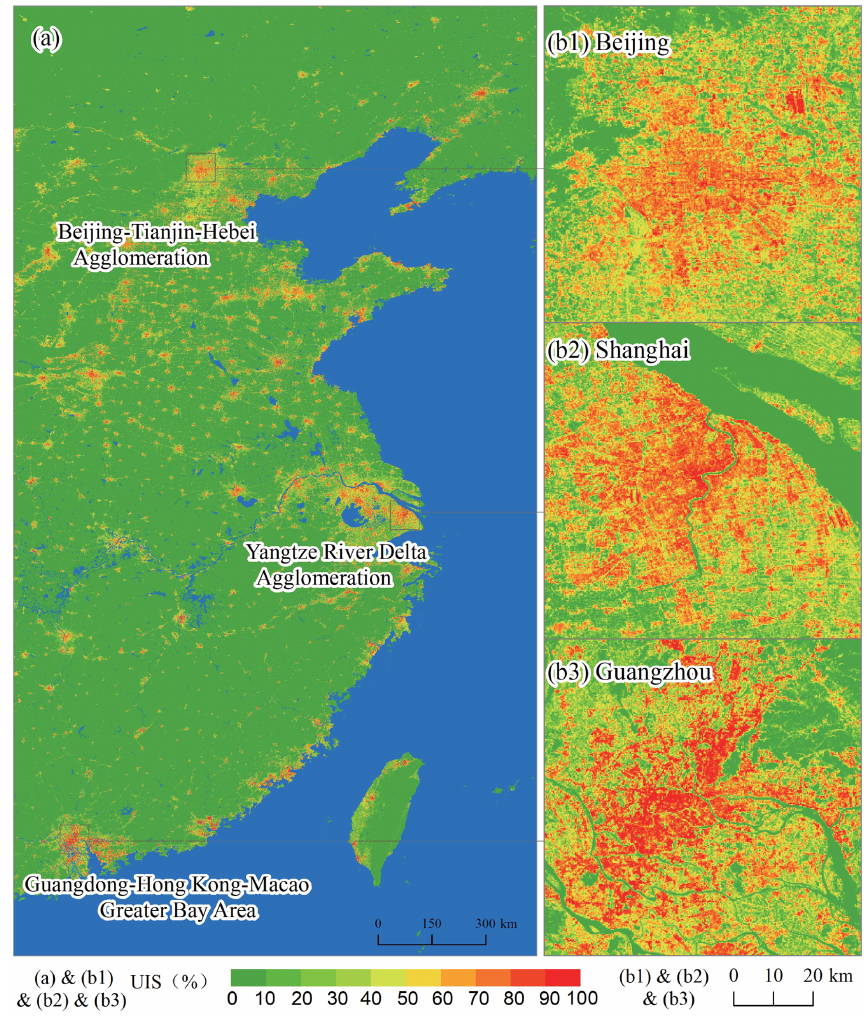
Figure 6. Distribution of sampling cities in China and training samples in selected cities. The administrative boundaries and residential point information were provided by the National Geomatics Center of China (http://www.webmap.cn, last access: 15 September